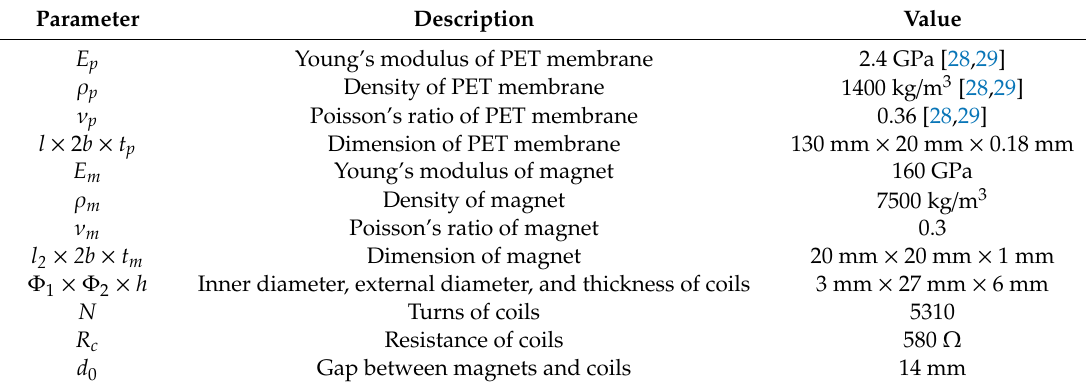
Figure 1. Schematic diagram of the flutter-based electromagnetic energy harvester. Table 1. Material and structural parameters of the device.